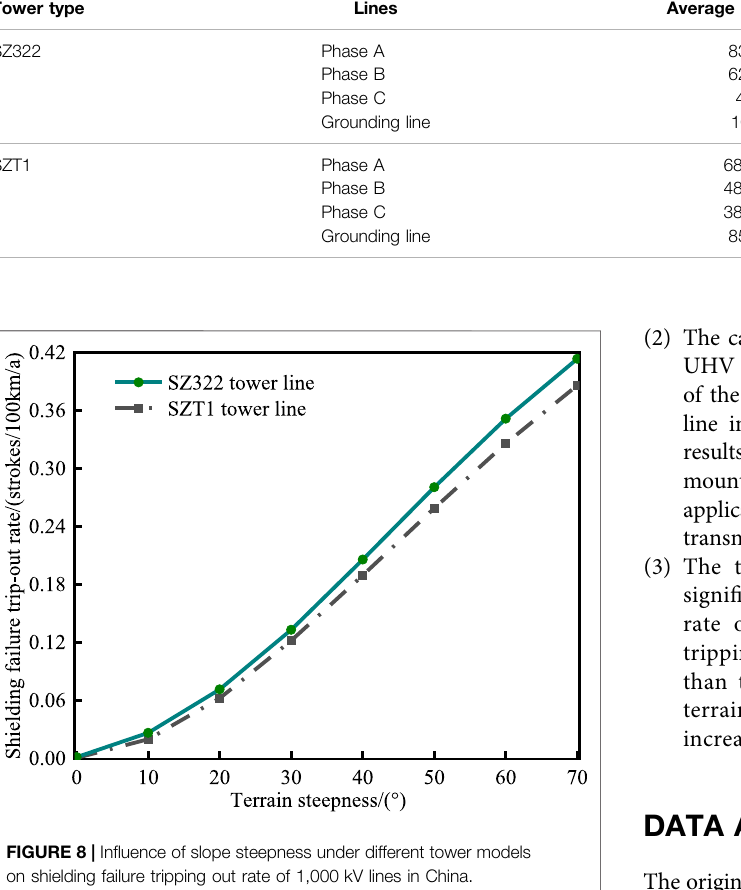
Frontiers in Energy Research |